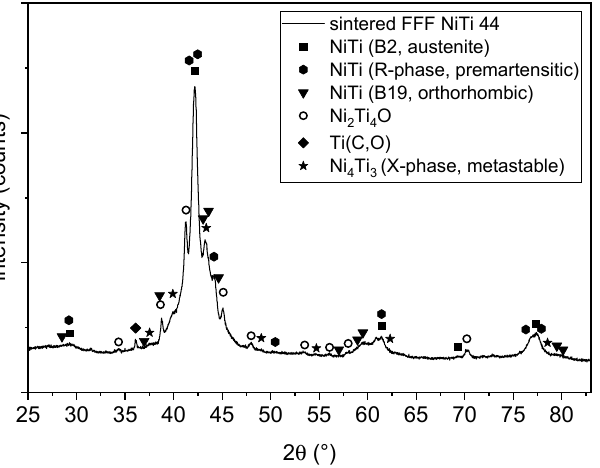
Figure 11. XRD analysis of the sintered sample showing a mixture of different phases. Next to the Ni-Ti phases in different modifications, Ni 2 Ti 4 O and Ti(C, O) also appear in the sample.